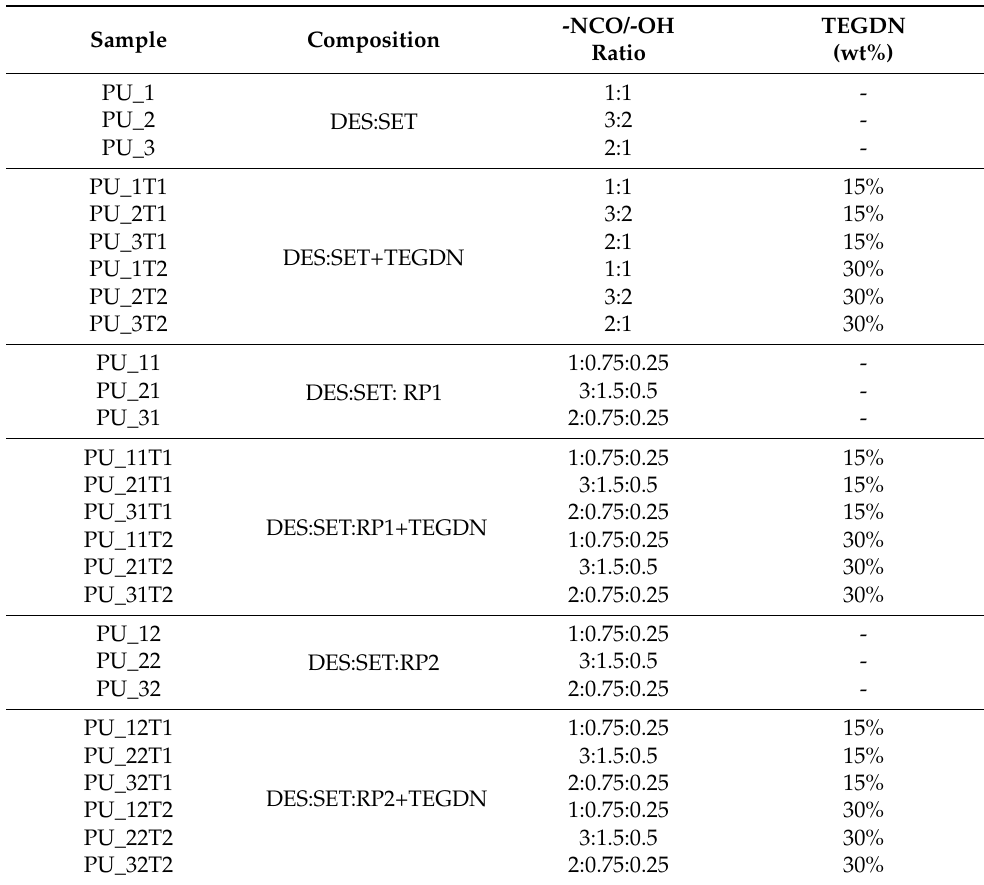
Table 2. Composition of the polyurethane